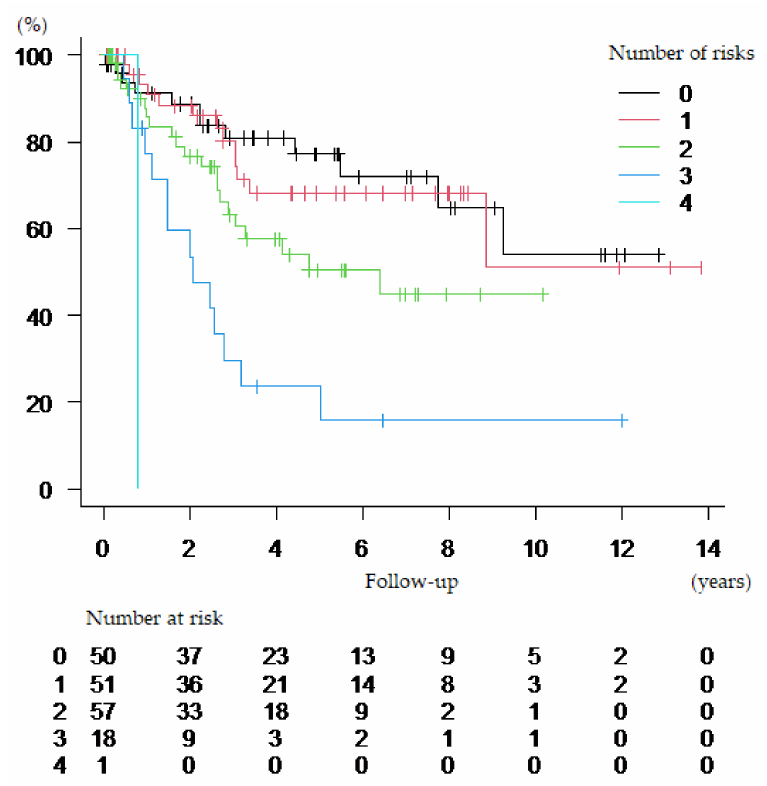
Figure 2. Kaplan–Meier curves for overall survival according to the number of risks.